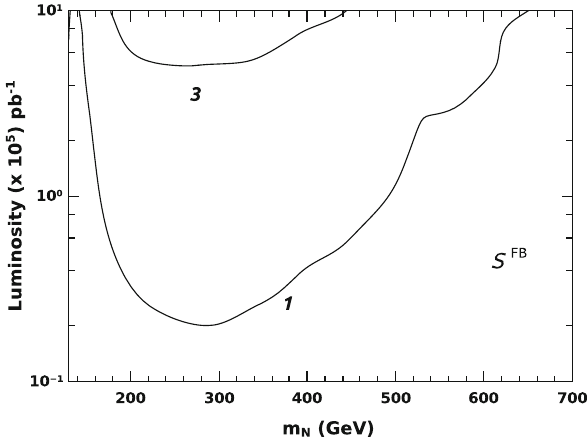
Fig. 6 Asymmetry in the angular distribution of the final anti-lepton, with the errors estimates as defined in the text